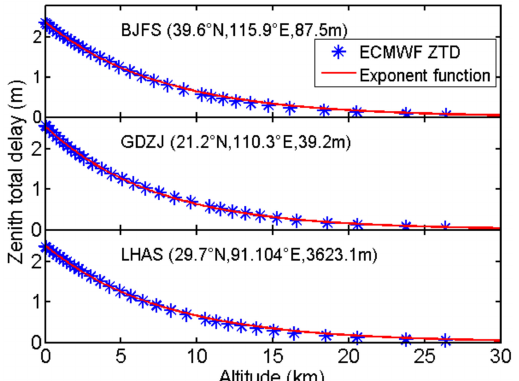
Figure 1. Profiles of ZTD at the nearest grid points of the GPS stations, BJFS, GDZJ and LHAS at UTC 0, 1 April 2014.